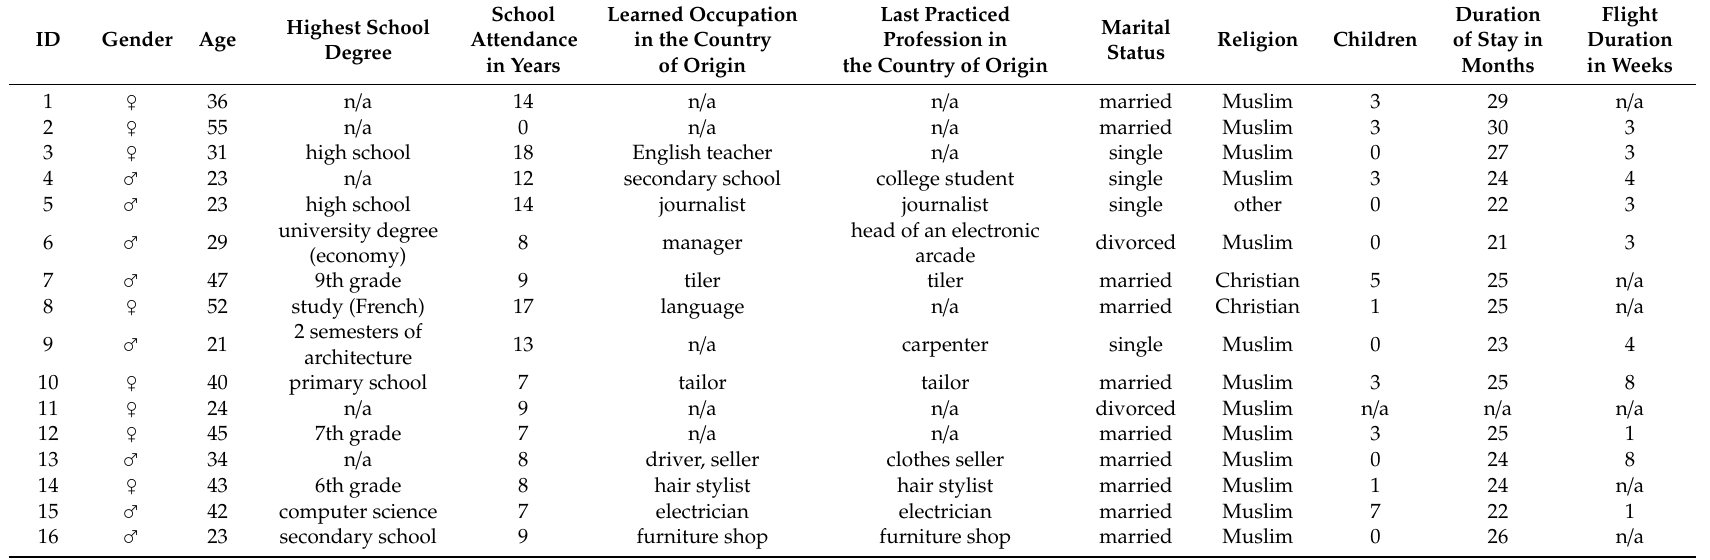
Table 1. Socio-demographic